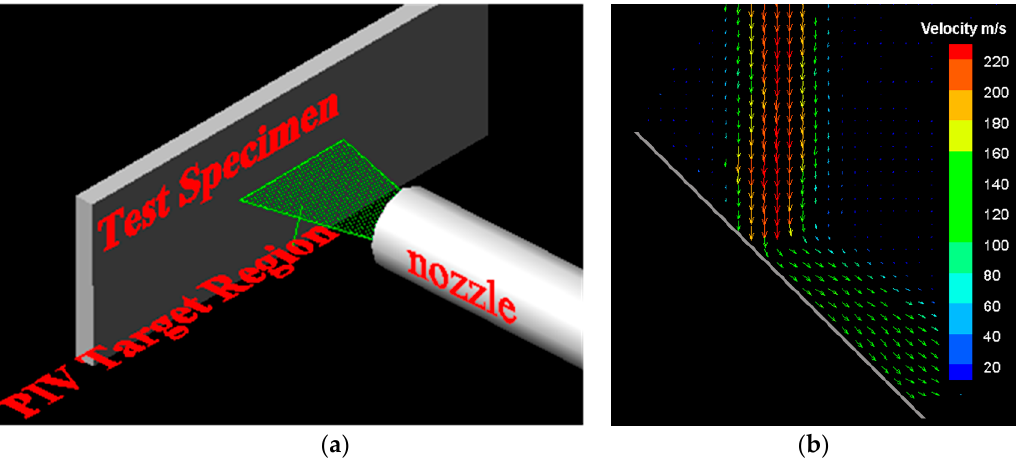
Figure 4. Schematic of the particle velocity field measurement by particle image velocimetry (PIV): ( a ) Test principle of PIV; ( b ) D 32 = 65 μ m under 210 m/s, 566 °C and 45 °C condition.